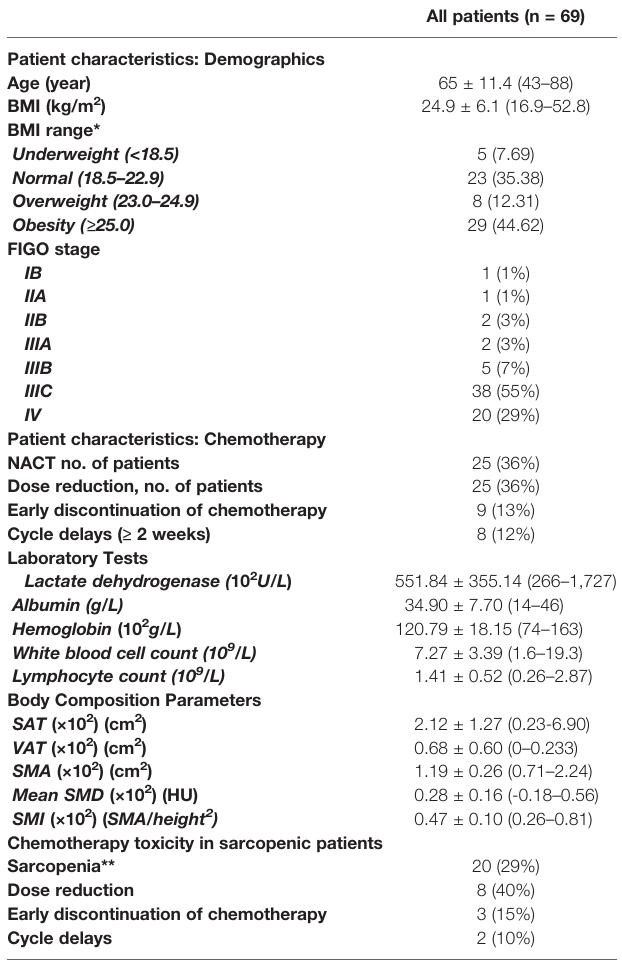
All patients (n = 69)